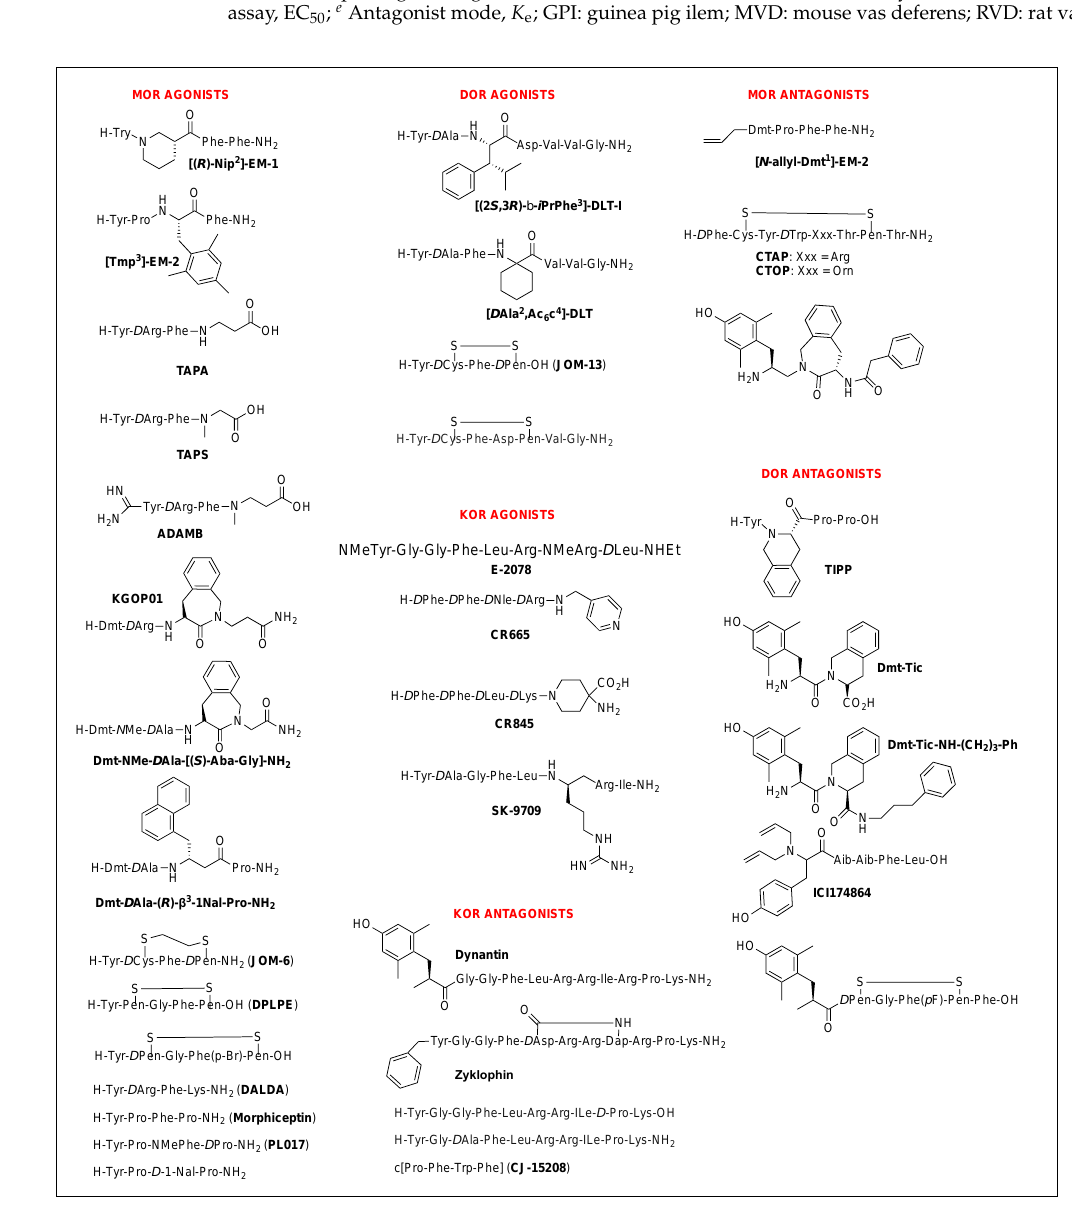
a The variability in the binding and functional data between various laboratories may be attributed to differences in the synaptosomal preparations, the concentration, type of radioligand, and specific activity used, and the method of reporting binding. Refer to the citations for the details. b Ca Assay, EC 50 ; c cAMP Assay, EC 50 ; d GTP assay, EC 50 ; e Antagonist mode, K e ; GPI: guinea pig ilem; MVD: mouse vas deferens; RVD: rat vas deferens.